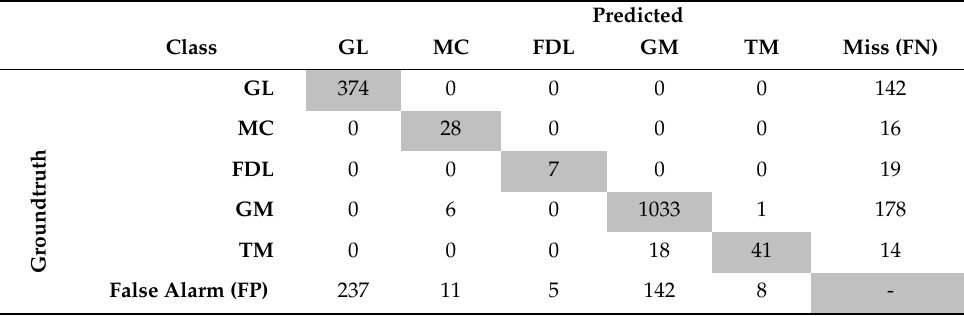
Figure 9. Examples of detections predicted by faster R-CNN ResNet101 model on delta ( left ) and sticky trap ( right ) images from the test set. The ground truth annotations are marked in white, whereas GM predictions are in cyan, TM in turquoise, MC in purple, GL in green, and FDL in red. Table 11. Confusion matrix for final faster R-CNN ResNet101 model on the test set, using a score threshold of 0.05 and 0.1 NMS